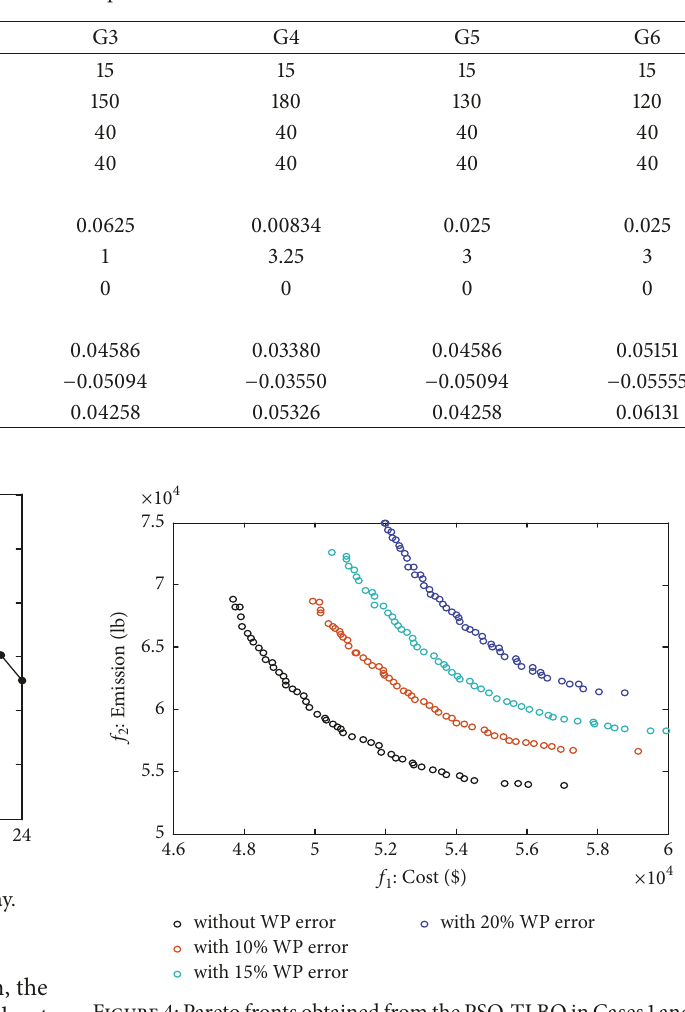
Figure 4: Pareto fronts obtained from the PSO-TLBO in Cases 1 and 2.